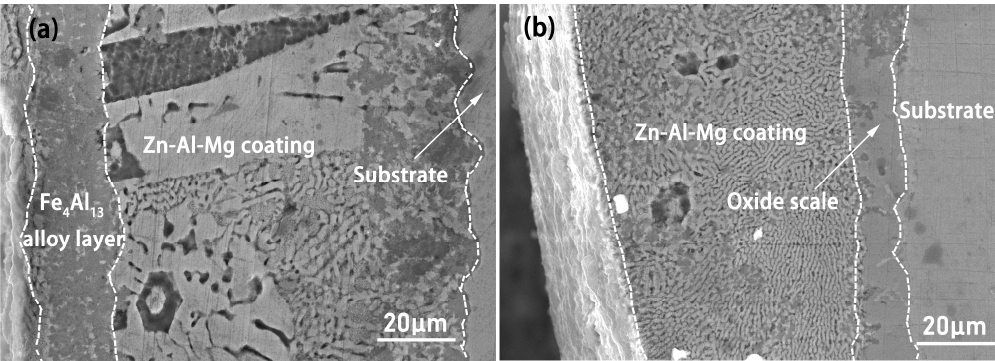
Figure 11. Microstructure of cross section of coatings. ( a ) Polished steel plate, ( b ) Unpolished steel plate.